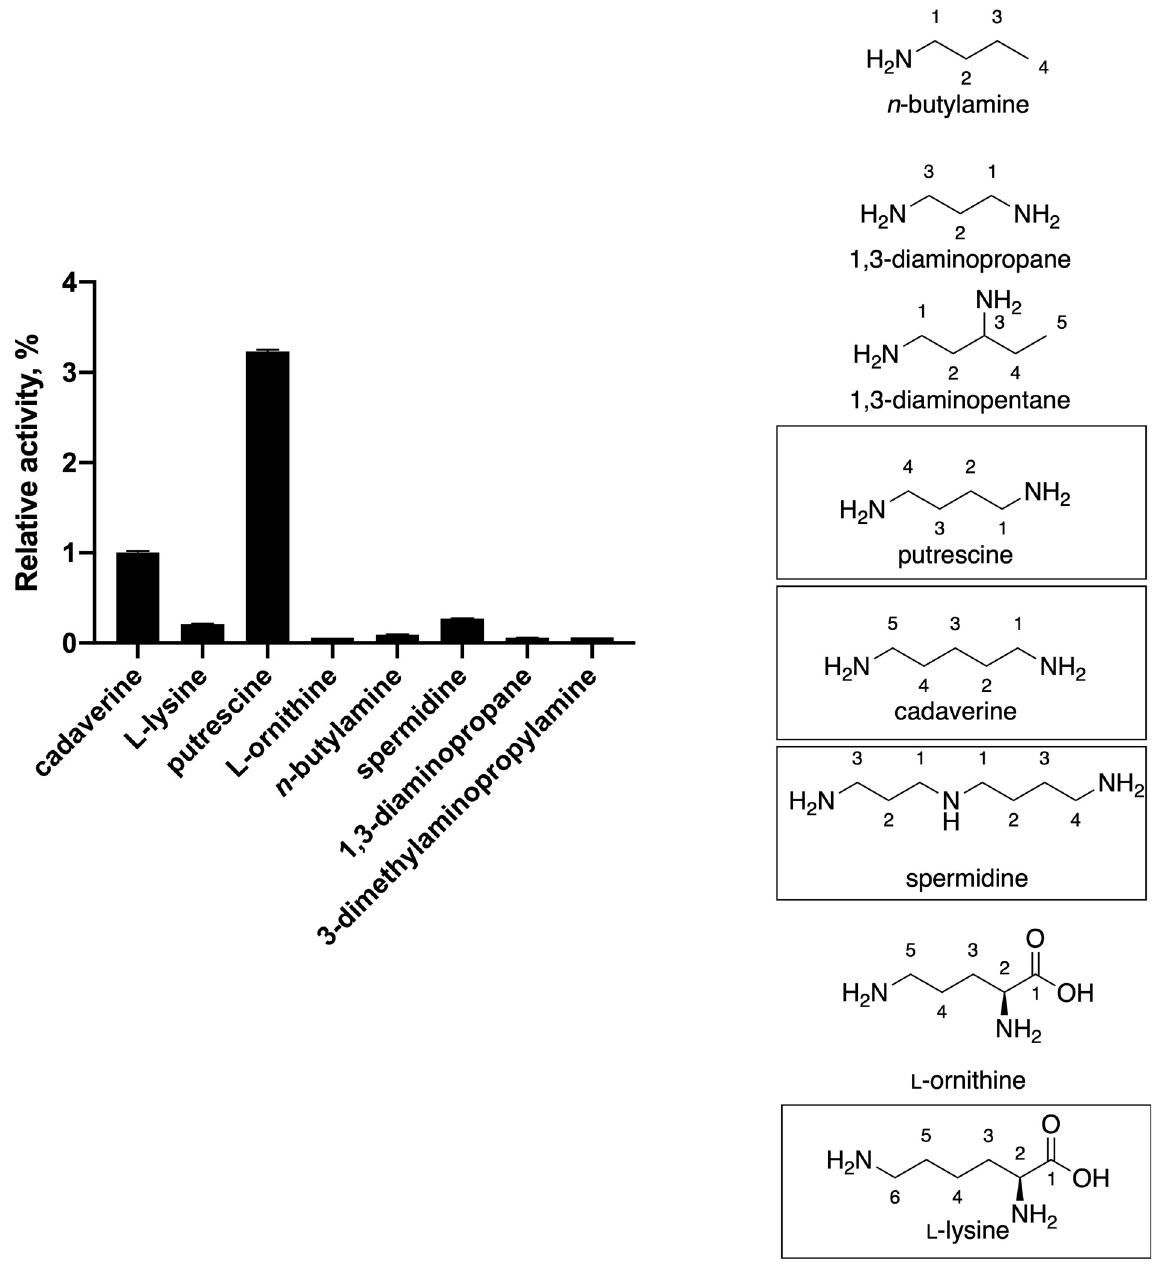
Fig 5. Relative Ss DesB activity with different substrates. Initial rates measured with 10 mM L-lysine, cadaverine, spermidine, putrescine, n - butylamine, L-ornithine, 1,3-diaminopropane, and 3-dimethylaminopropylamine in product formation assays in the presence of Ss DesB, 50 μ M FAD, and 0.7 mM NADPH. All initial rates are relative to that of cadaverine. n -Butylamine, L-ornithine, 1,3-diaminopropane, and 3-dimethylaminopropylamine did not yield any Fmoc-derivatized N -hydroxylated products by LC/MS. All assays were performed in triplicate and molecular structures are shown with numbered carbon